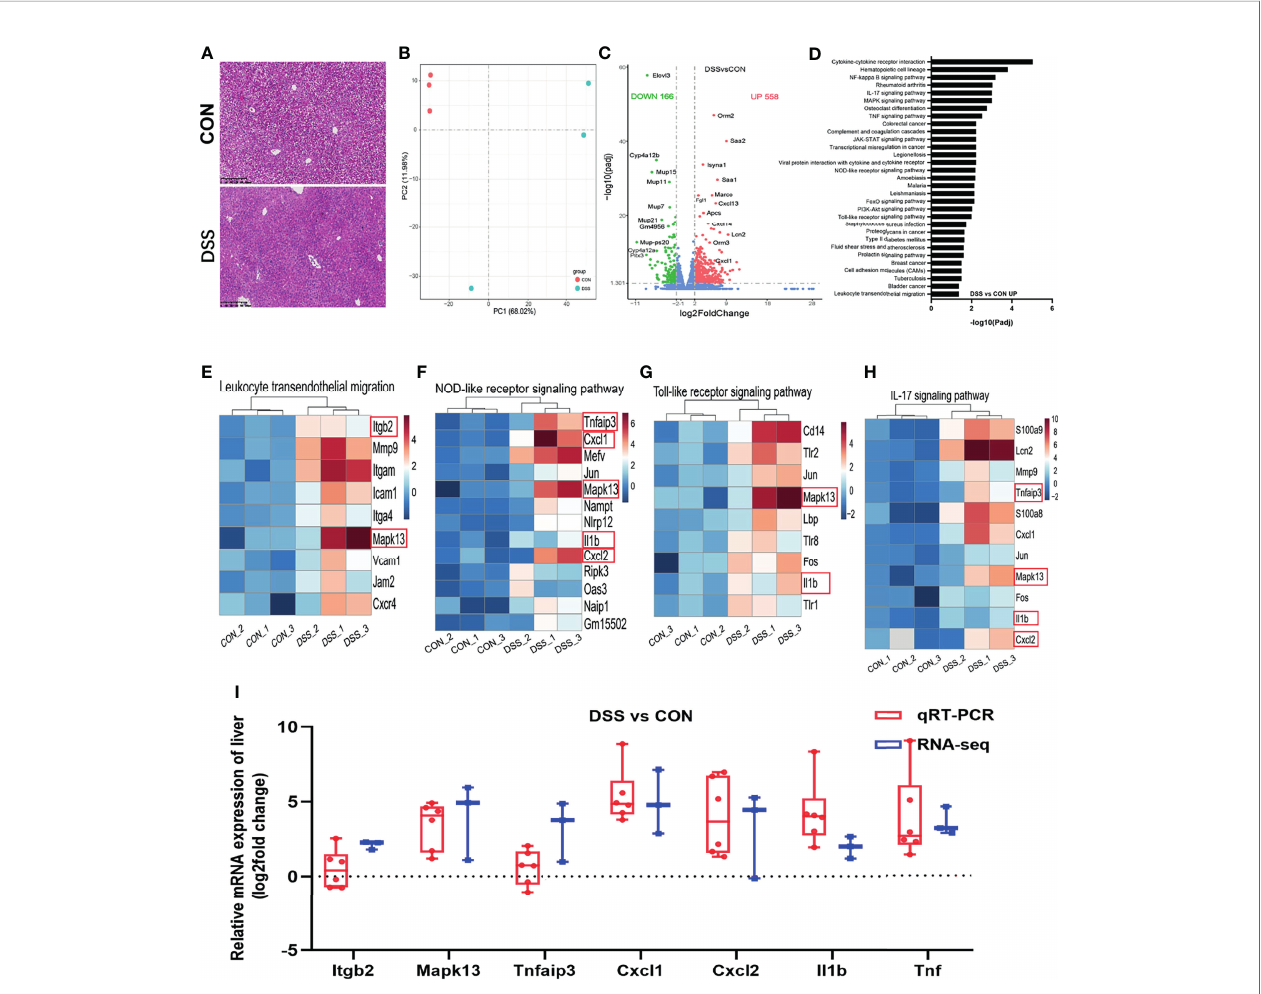
FIGURE 2 | Differentially expressed genes in the liver of healthy (CON) and acute colitis (DSS) mice. (A) H&E staining of liver, the bars represent 100 m m; (B) PCA plot colored by DSS group samples in green and CON groups samples in red; (C) Volcano plot showing the changes of liver genes (fold change ≥ 2); (D) KEGG functional analysis reveals the biological functions that are enriched in the signi fi cantly up-regulated expressed genes; (E – H) Heatmap of 4 immune-related pathways enriched in the signi fi cantly up-regulated expressed genes; (I) qRT-PCR(n=6). con fi rmations of DEGs screened based on RNA-seq analysis